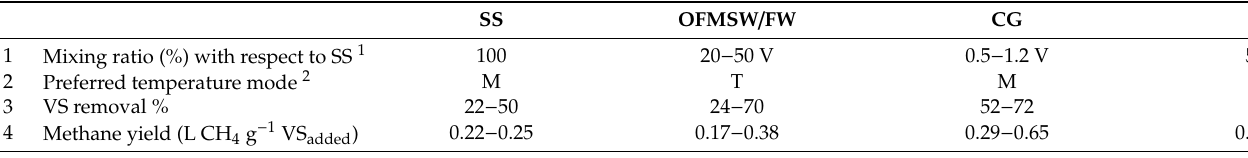
Table 6. Summary of reviews on co-substrates (at OLR = 1 − 2.5 gVS L − 1 d − 1 and HRT = 15 − 30